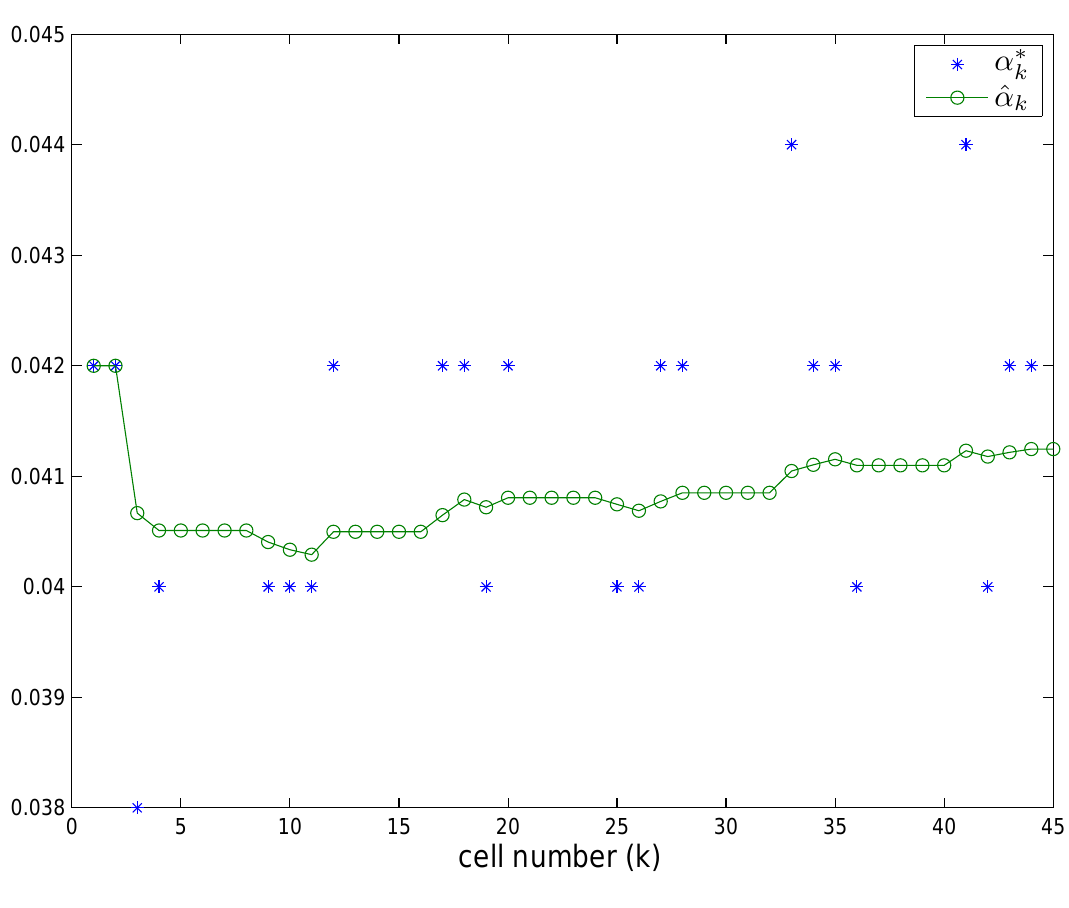
Figure 12. (cid:11) (cid:3)